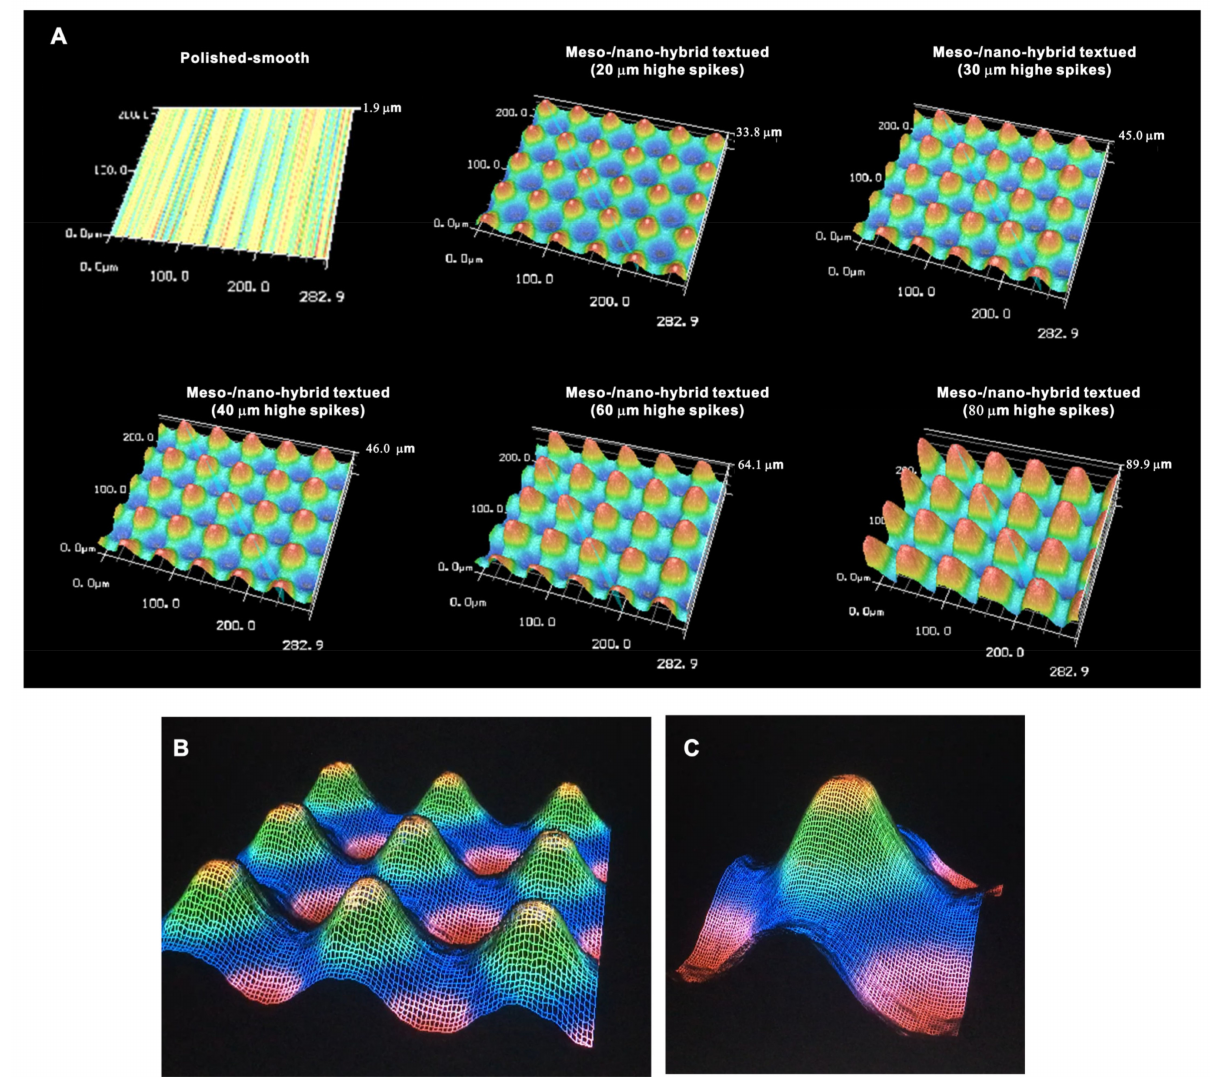
Figure 3. Three-dimensional profiles of the bio-inspired meso- and nano-scale hybrid textured zirconia. ( A ) Three- dimensional images of the polished zirconia and the meso- and nano-scale textured zirconia with various heights of meso-spikes. ( B , C ) Close-up images of the 40 µ m-high meso-spikes, depicting precise and smooth transitions from peaks to